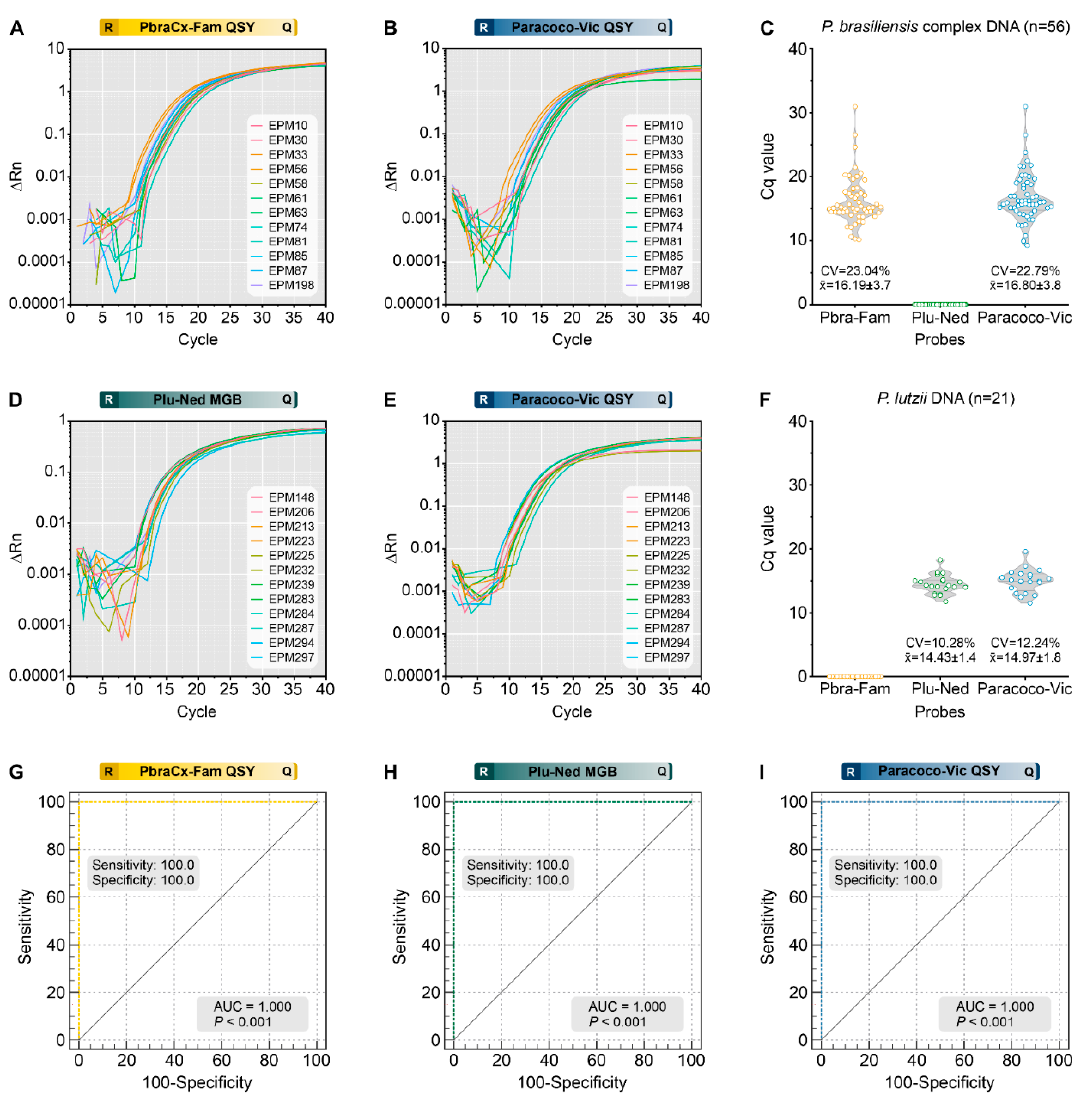
Figure 4. Assessment of analytical specificity of a triplex-probe qPCR assay for Paracoccidioides species. The representative ampli fi cation plot for PbraCx-Fam probe ( A ) or Paracoco-Vic probe ( B ) and the DNA of members of the P. brasiliensis complex; ( C ) Sca tt er plot of Cq values (y-axis) from a group of 56 P. brasiliensis complex DNA, including P. brasiliensis s. str. (n = 42), P. americana (n = 6), P. restrepiensis (n = 5), and P. venezuelensis (n = 3). The representative ampli fi cation plot for Plu-Ned